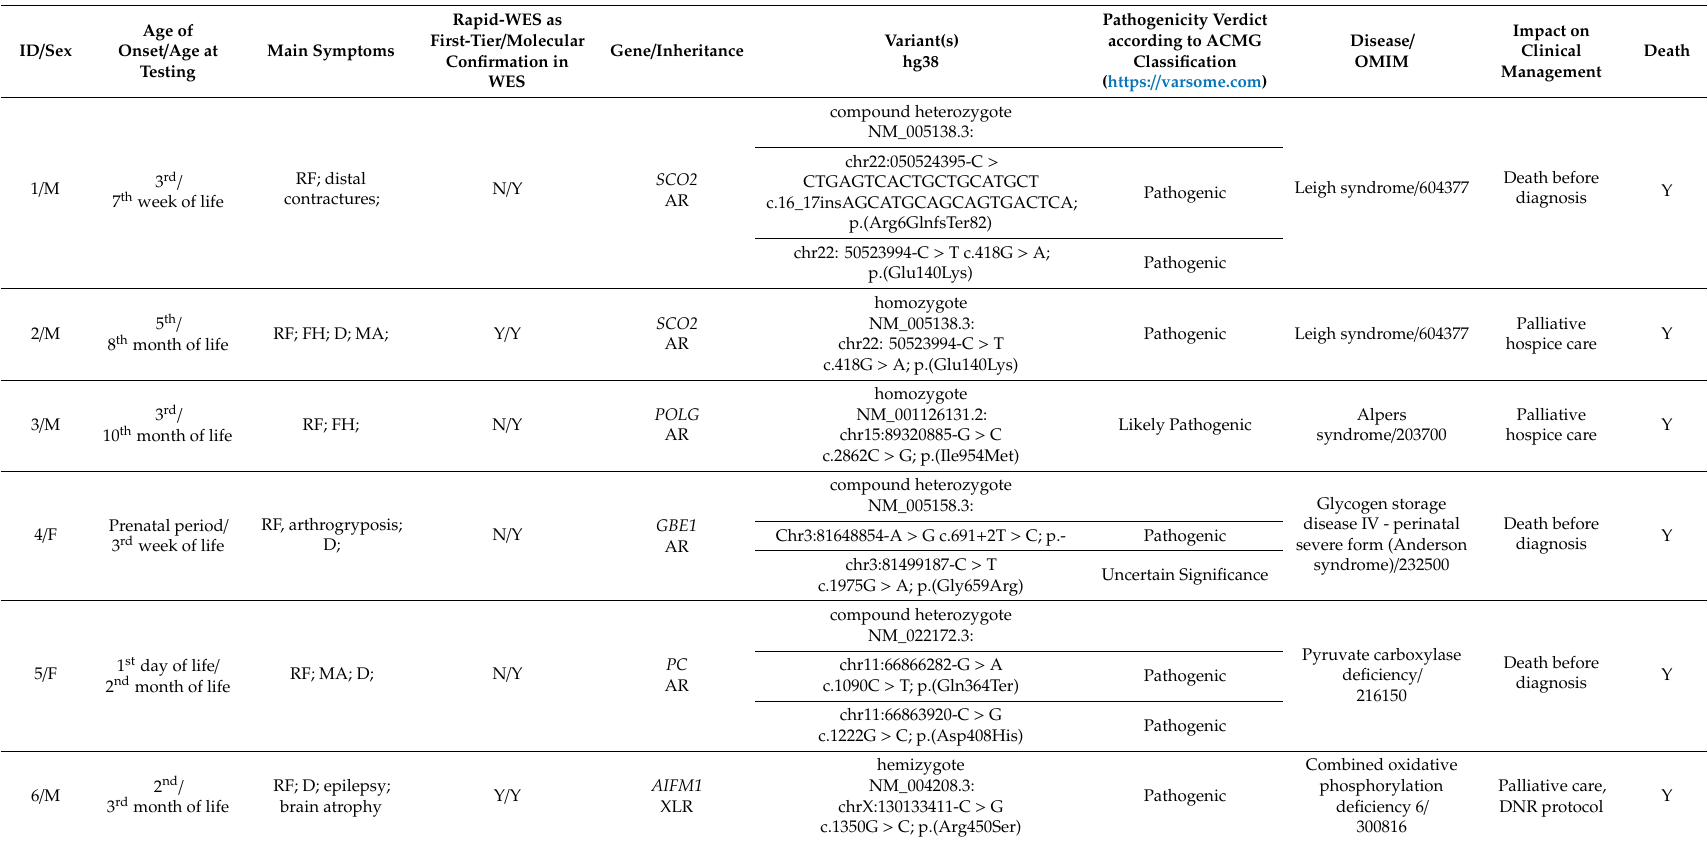
Table 2. Clinical characteristics, identified genes, and sequence variants in the patients. M—male; F—female; RF—respiratory failure;